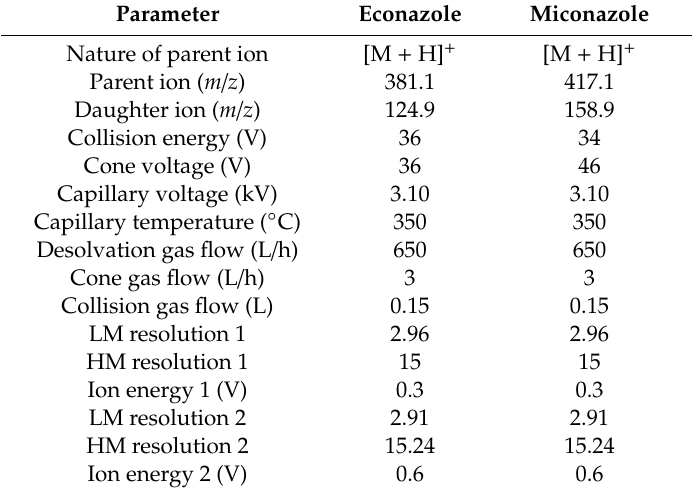
Table 1. MS / MS Setting for detection of econazole nitrate (ECZ) and miconazole nitrate